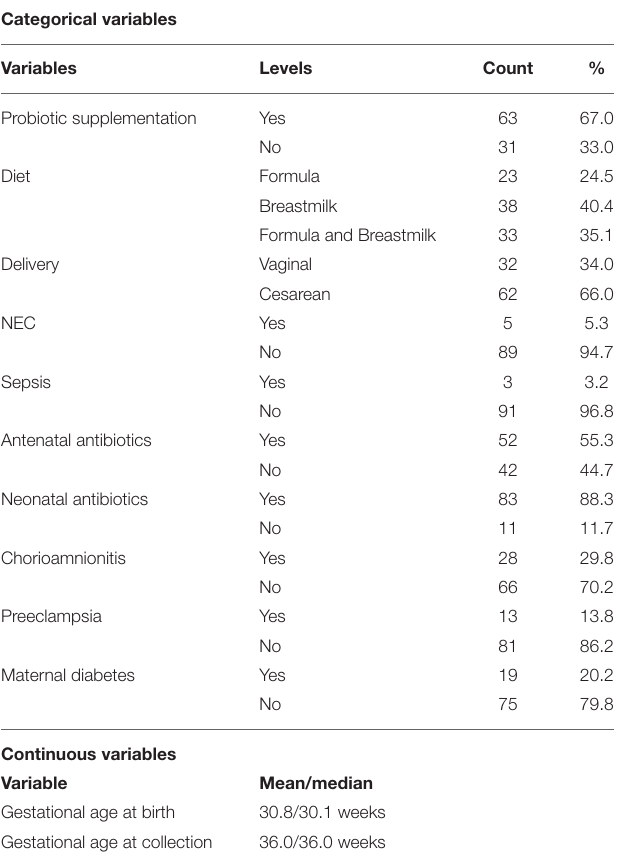
TABLE 1 | Overview of the demographic data for the preterm-infant cohort that underwent 16 rRNA gene amplicon sequencing. Categorical